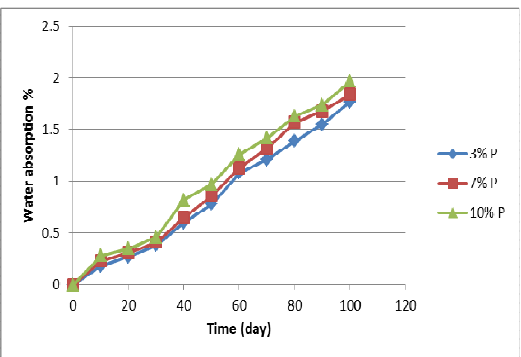
Fig. 12. Effect of pomegranate husk particles on water absorption.